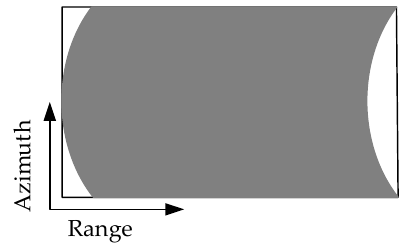
Figure 1. Radar flight geometry. Figure 2. Schematic diagram of two-dimensional (2D) echo with azimuth complete sampling data.